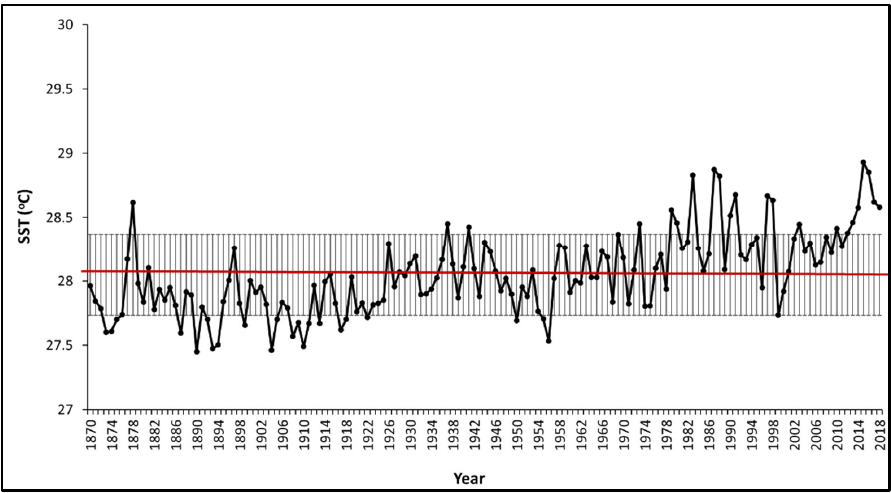
Figure 4. Annual SST variation in the study area from 1870 to 2018. The red line indicates the average SST (28.04 °C) during the study period. The black, straight lines indicate the standard deviation limits.